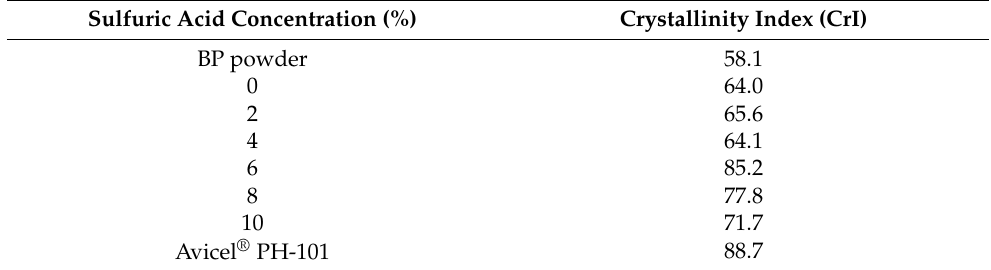
Table 3. Crystallinity index (CrI) of raw banana peel and after hydrolysis with 0 to 10% sulfuric acid. Sulfuric Acid Concentration